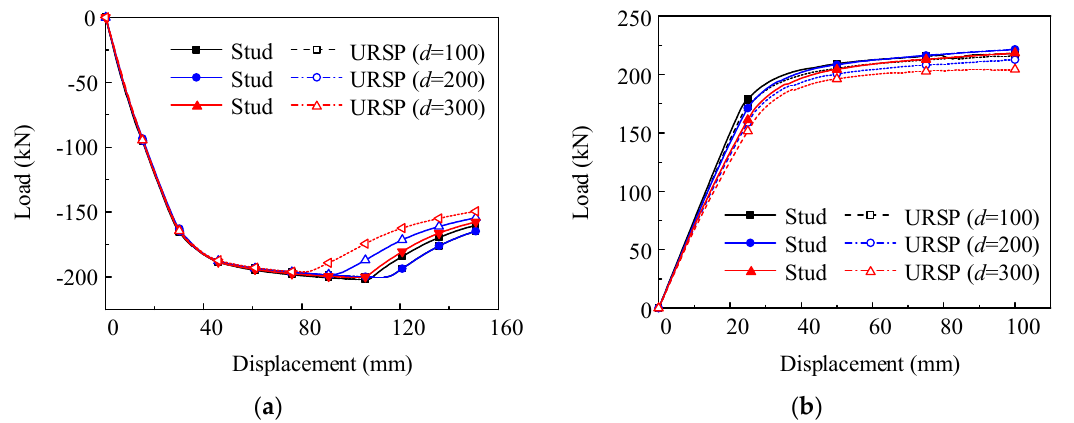
Figure 13. Load-displacement curves with different degrees of shear connection. ( a ) Hogging moment; ( b ) sagging moment.